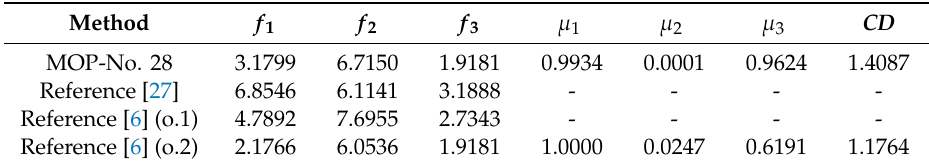
Table 3. Comparison of the solutions obtained with di ff erent methods when using the proposed objective function and